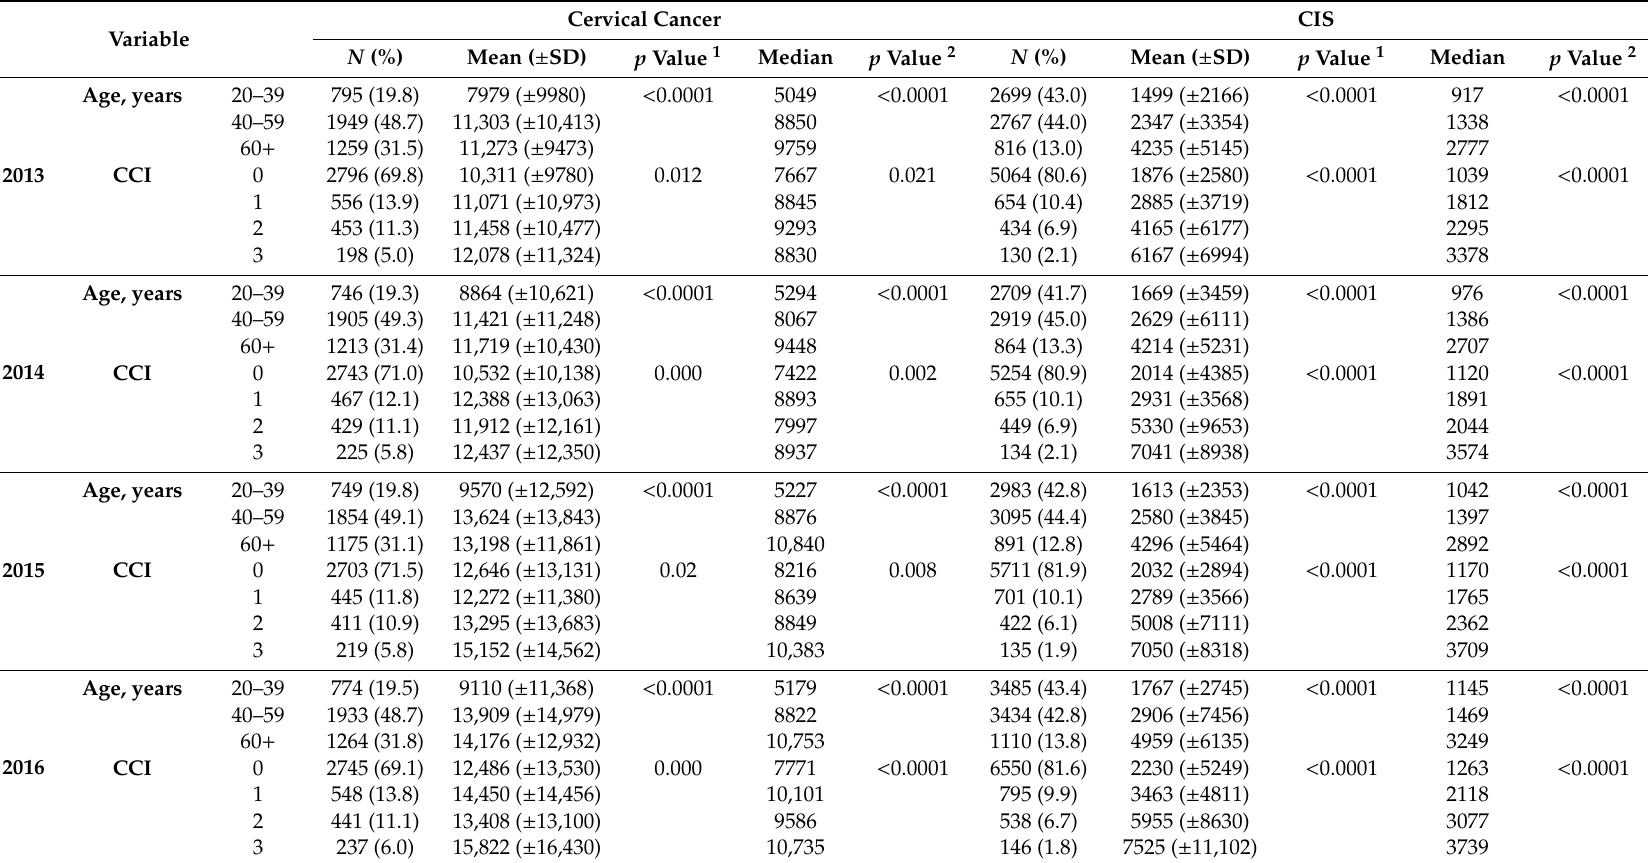
Table 1. The number of patients and distribution of cervical cancer and cervix uteri (CIS) between 2013 and 2016.